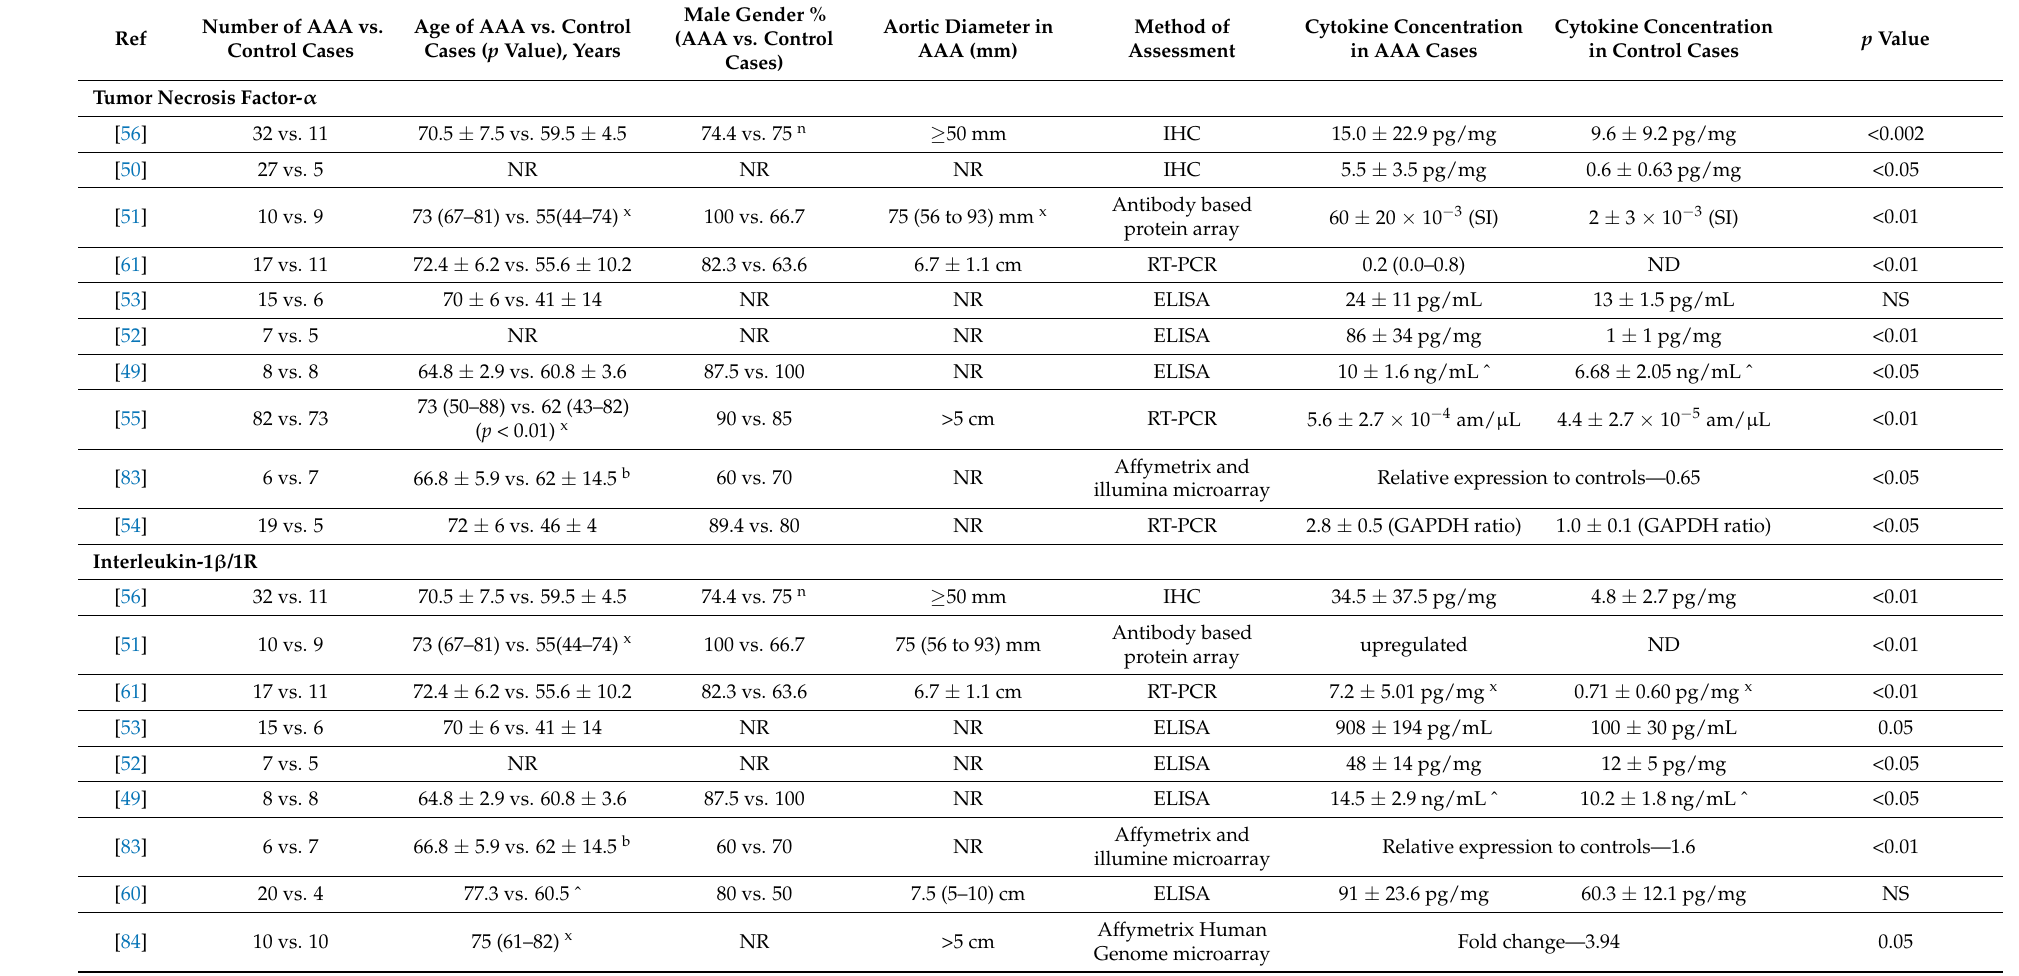
Table 4. Examples of clinical studies comparing tumor necrosis factor or interleukin expression levels in AAA and control tissue